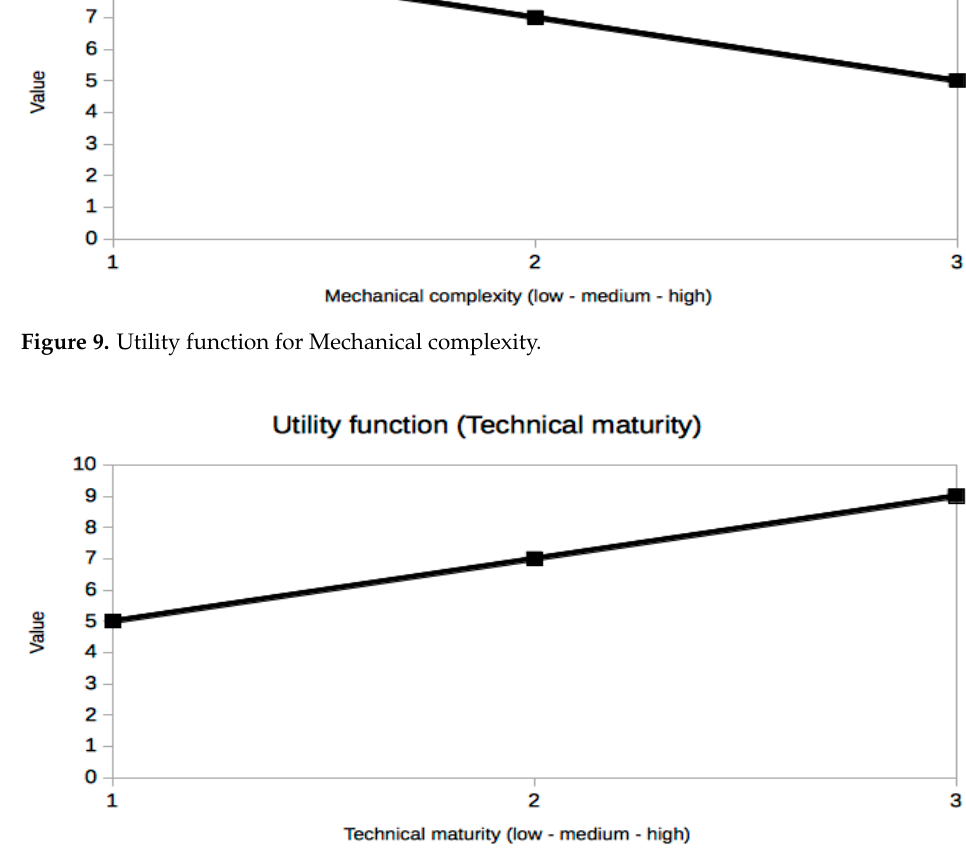
Figure 10. Utility function for Technical maturity.